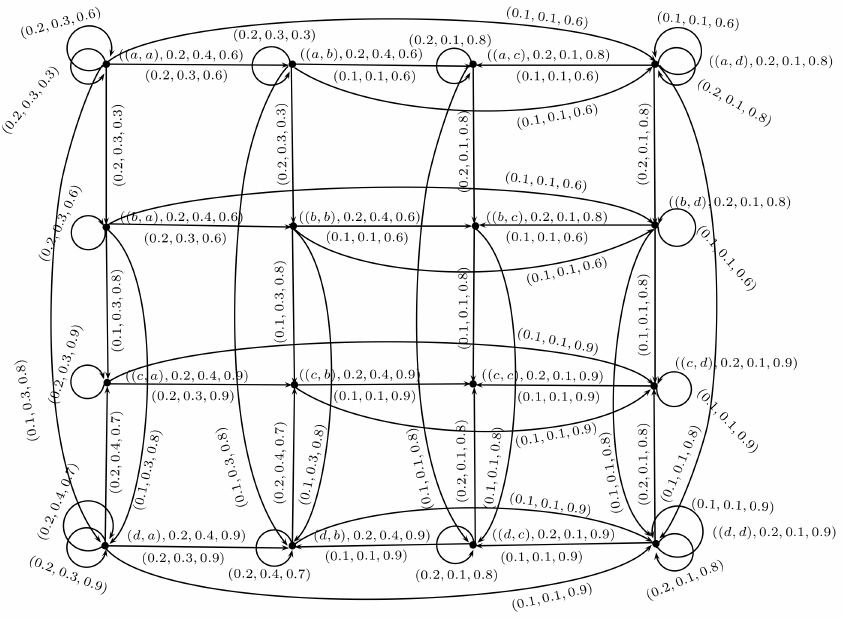
Figure 6. Neutrosophic digraph G 1 × G 2 = ( RN 1 × RN 2 , SE 1 × SE 2 ) .